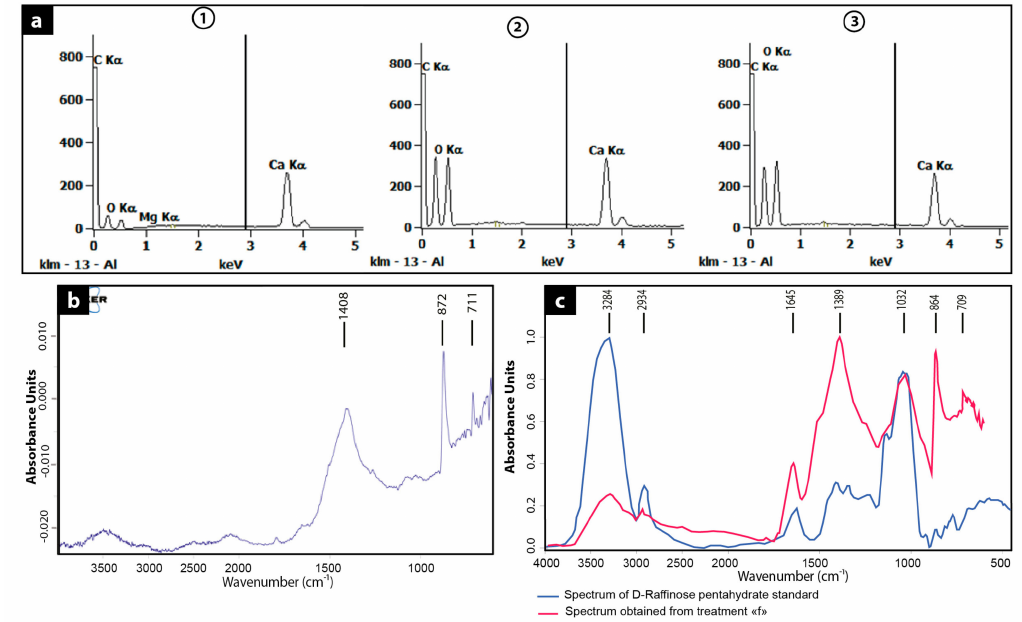
Figure 7. Spectra showing the chemical composition of the crystals, as analyzed by ( a ) EDS, ( 1 and 3 ) of micro-peloids and ( 2 ) of a rhombic crystal, ( b ) FT-IR, showing calcite peaks in a micro-peloid at 1408, 872, 711 cm − 1 and ( c ) a mixed signal of calcite and D-Ra ffi nose